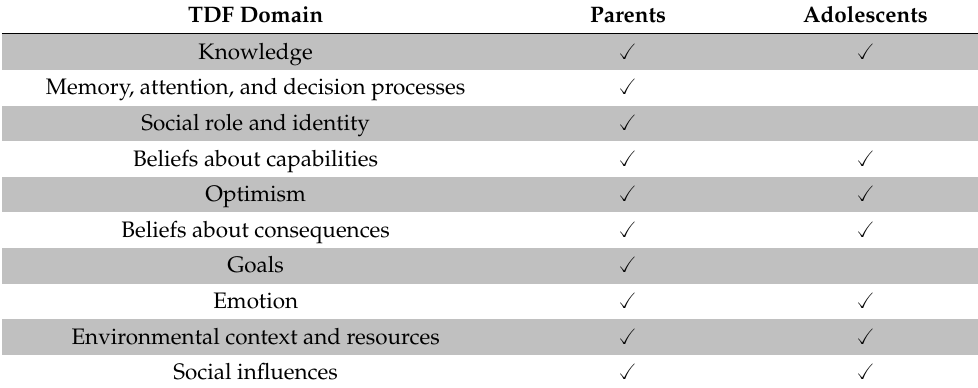
Table 1. Summary of Theoretical Domains Framework (TDF) domains identified in parents and adolescents through previous qualitative research.